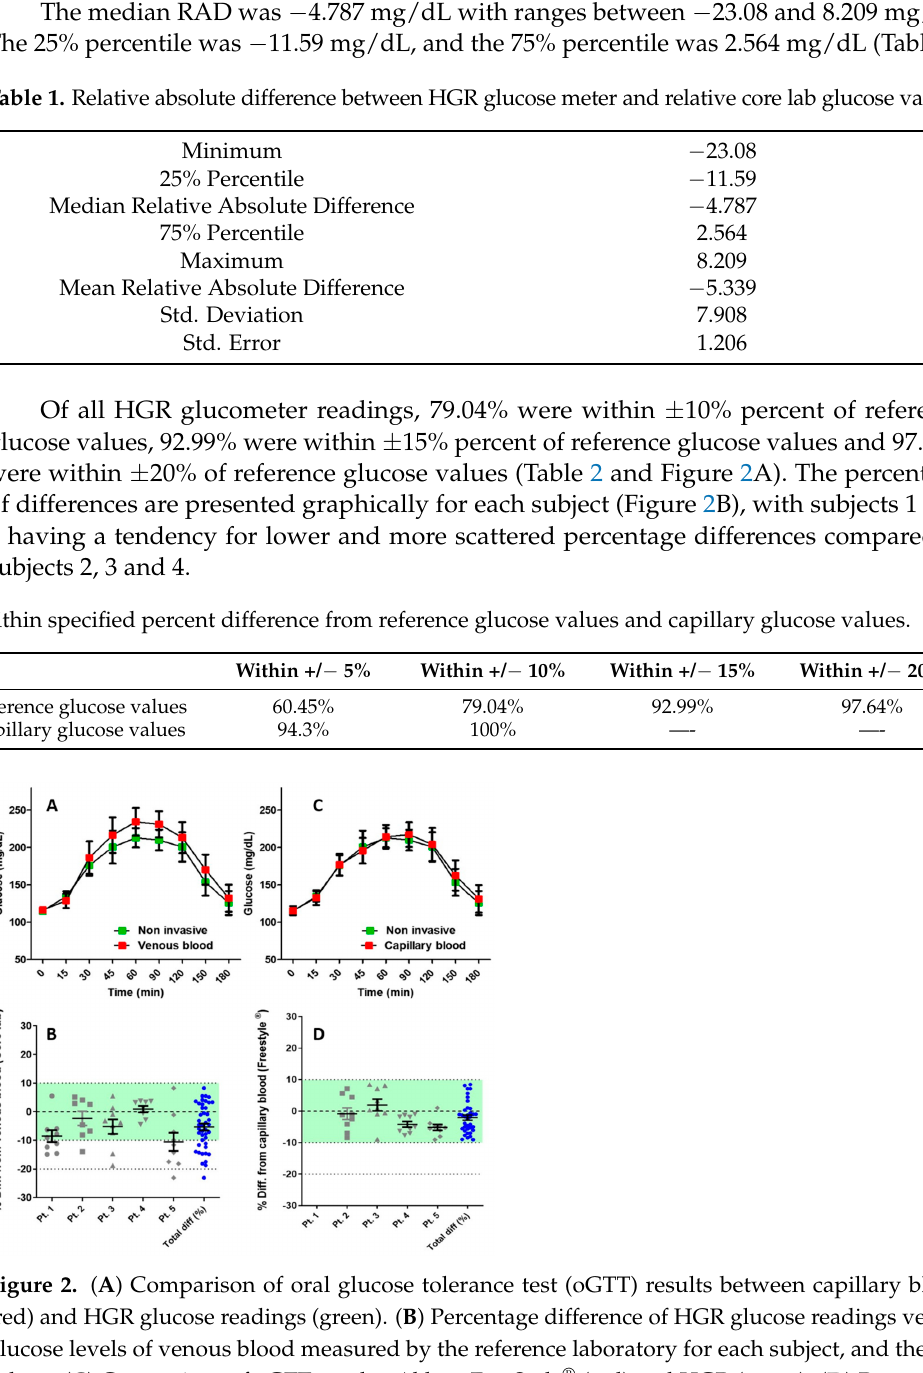
. Figure 3. ( A ) Pearson correlation between HGR glucose meter readings and venous blood glucose readings by reference lab. ( B ) Pearson correlation between HGR glucose meter readings and capil- lary blood glucose readings by Abbott FreeStyle ® glucose meters.